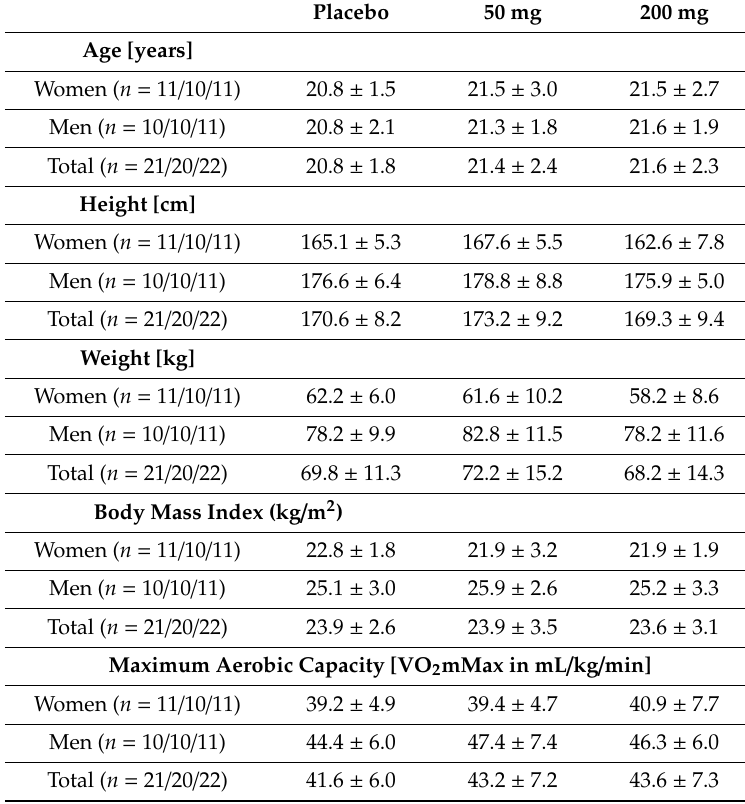
Table 1. Subject characteristics at baseline. Data is presented as means ± standard deviation. No significant di ff erences between groups were found at baseline ( p >